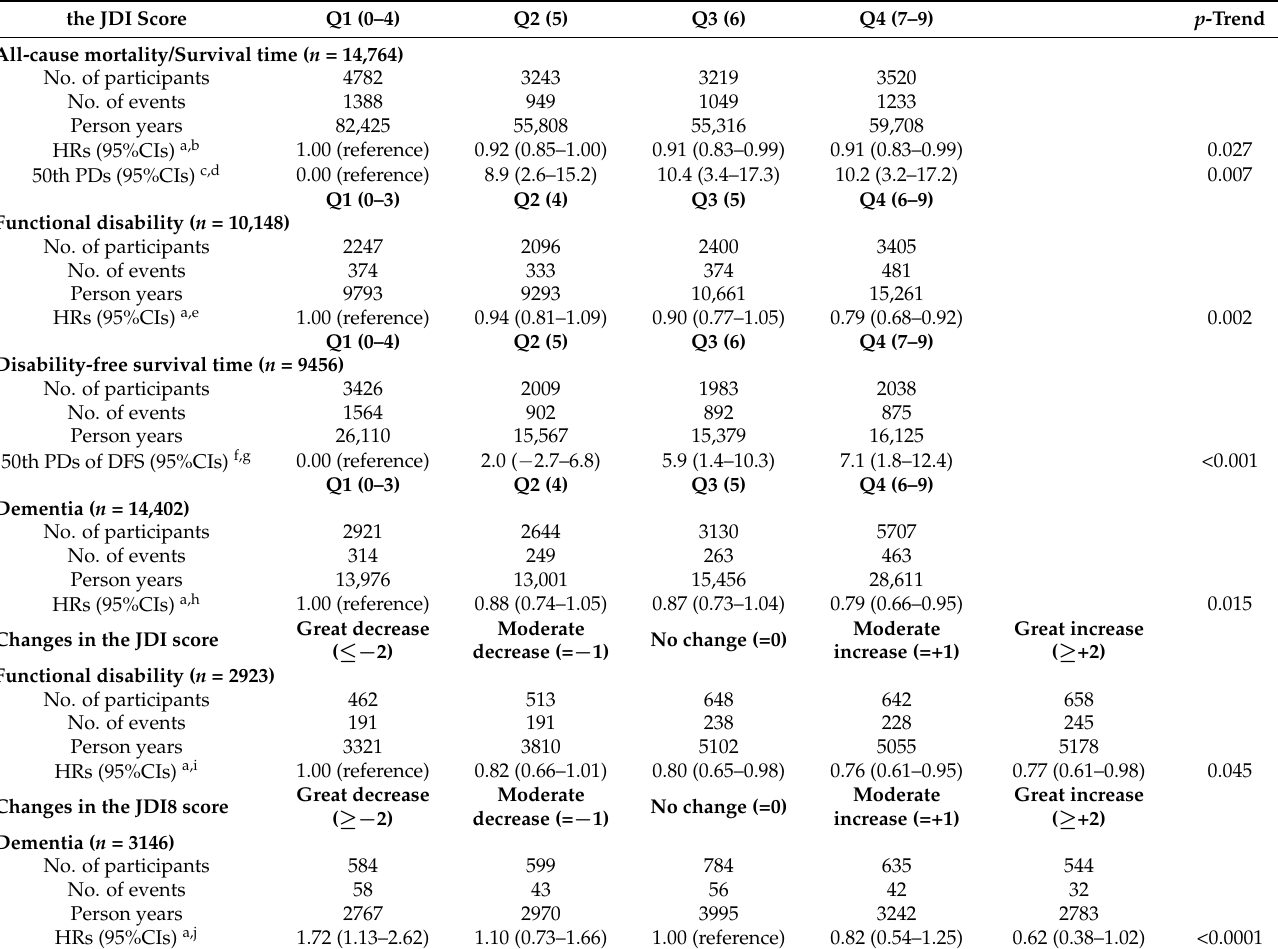
Table 2. Summary of published